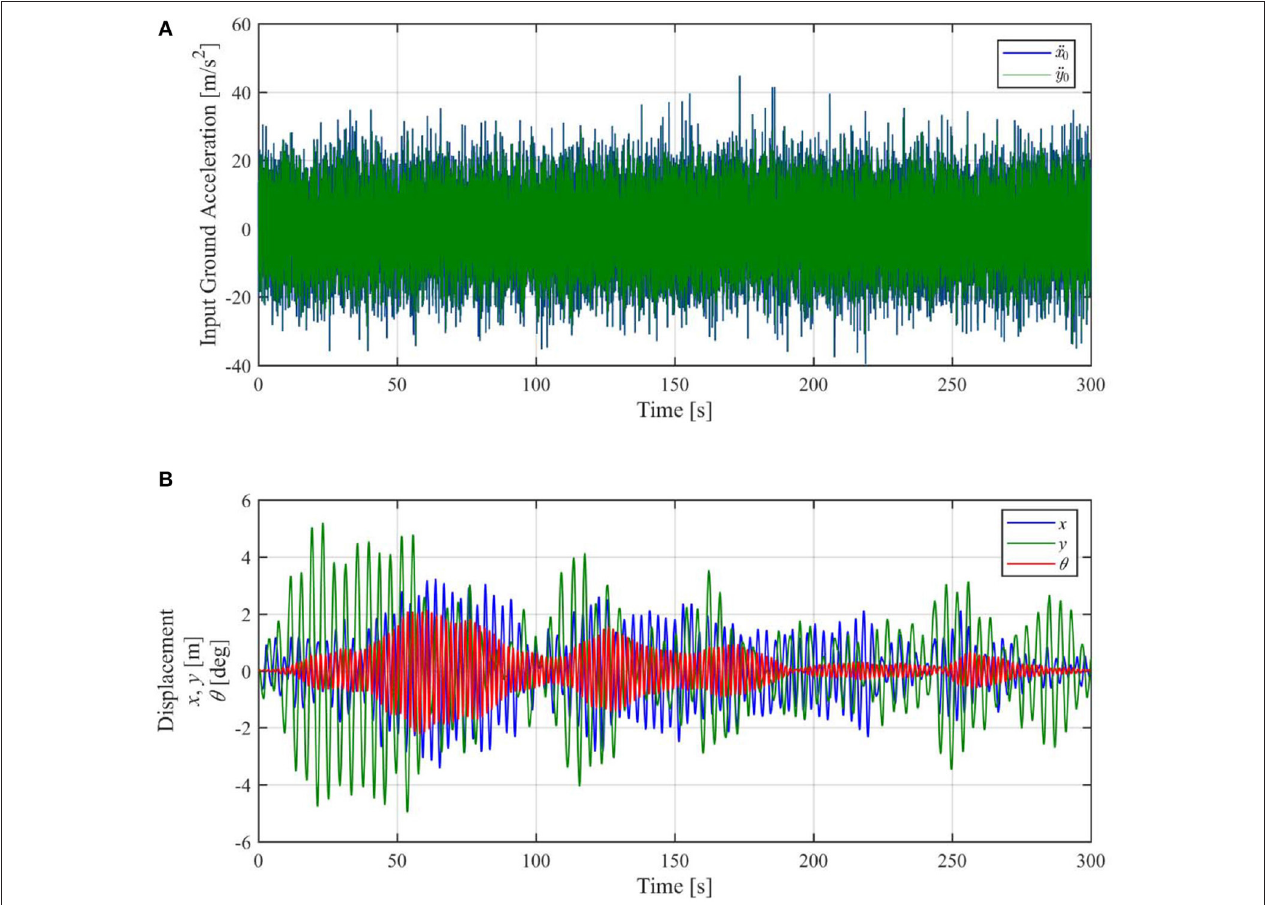
FIGURE 7 | Time-history analysis result of displacement response to one-directional (45 ◦ direction from the x axis) white noise ground acceleration. (A) Input ground acceleration, (B) Displacement